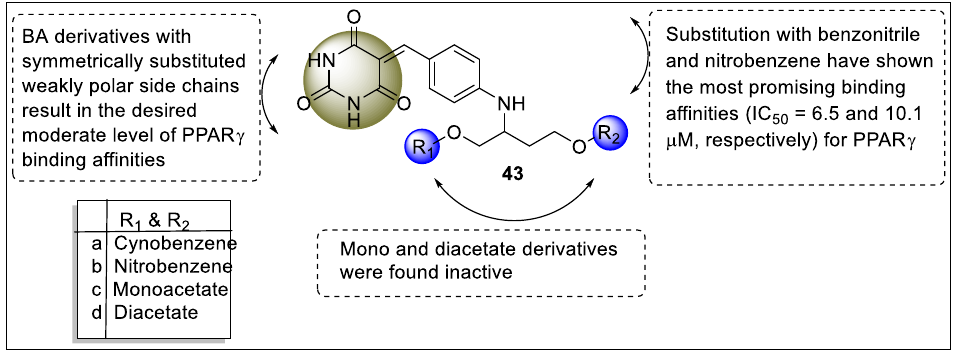
Figure 47. Structural activity relationship of barbituric acid (BA) hybrids ( 43 ) as potent PPAR ligands.